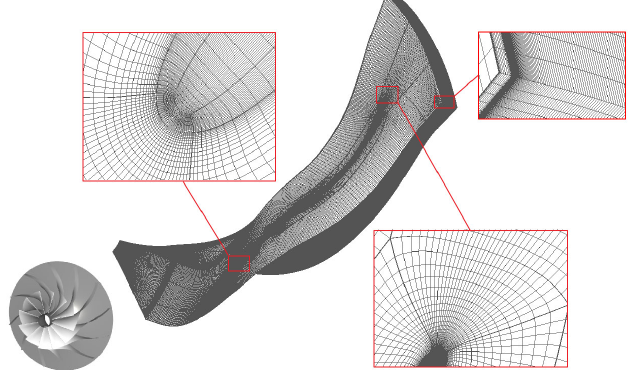
Figure 1. Computational domain and